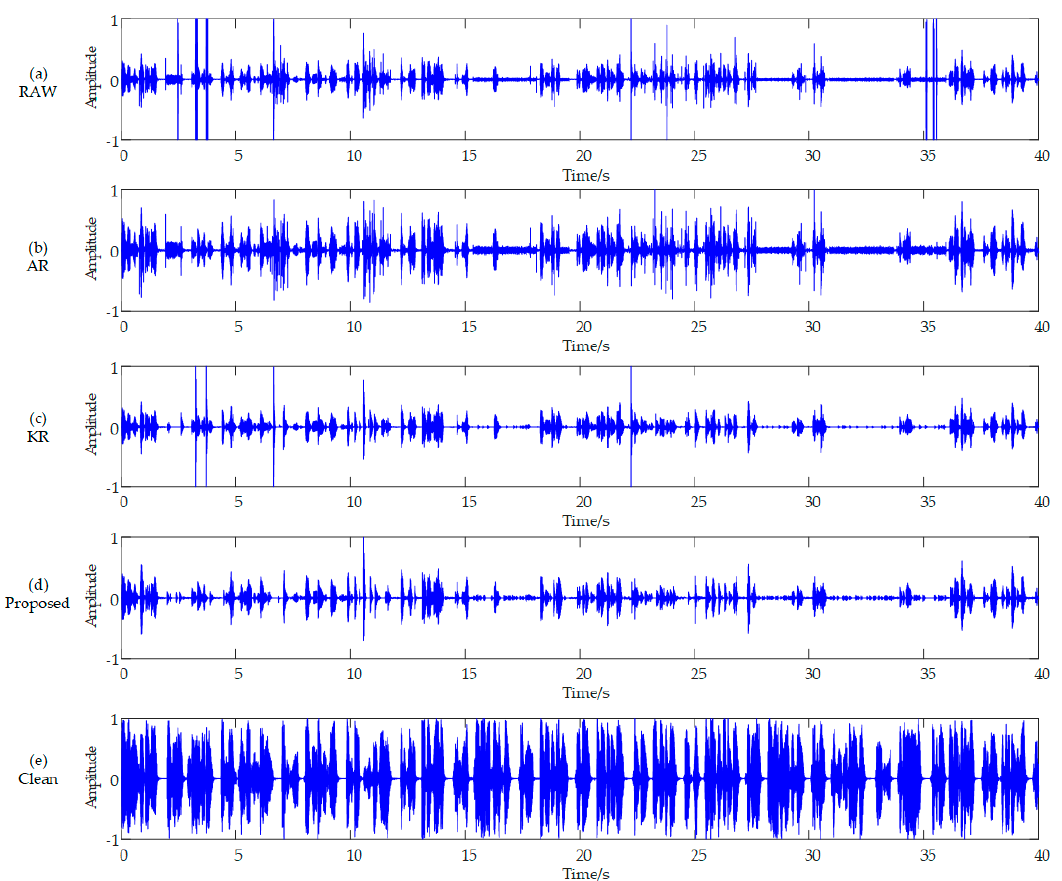
Figure 9. Laser captured speech signal and signal enhanced by different methods. ( a ) Raw signal; ( b ) AR results; ( c ) KR results; ( d ) proposed method results; ( e ) clean signal.